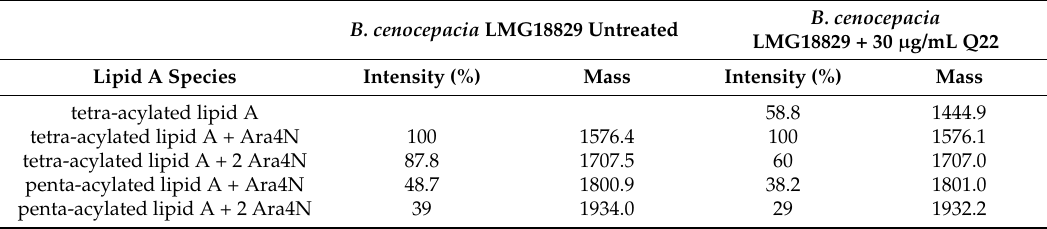
Table 2. Structural analysis of B. cenocepacia LMG18829 lipid A.